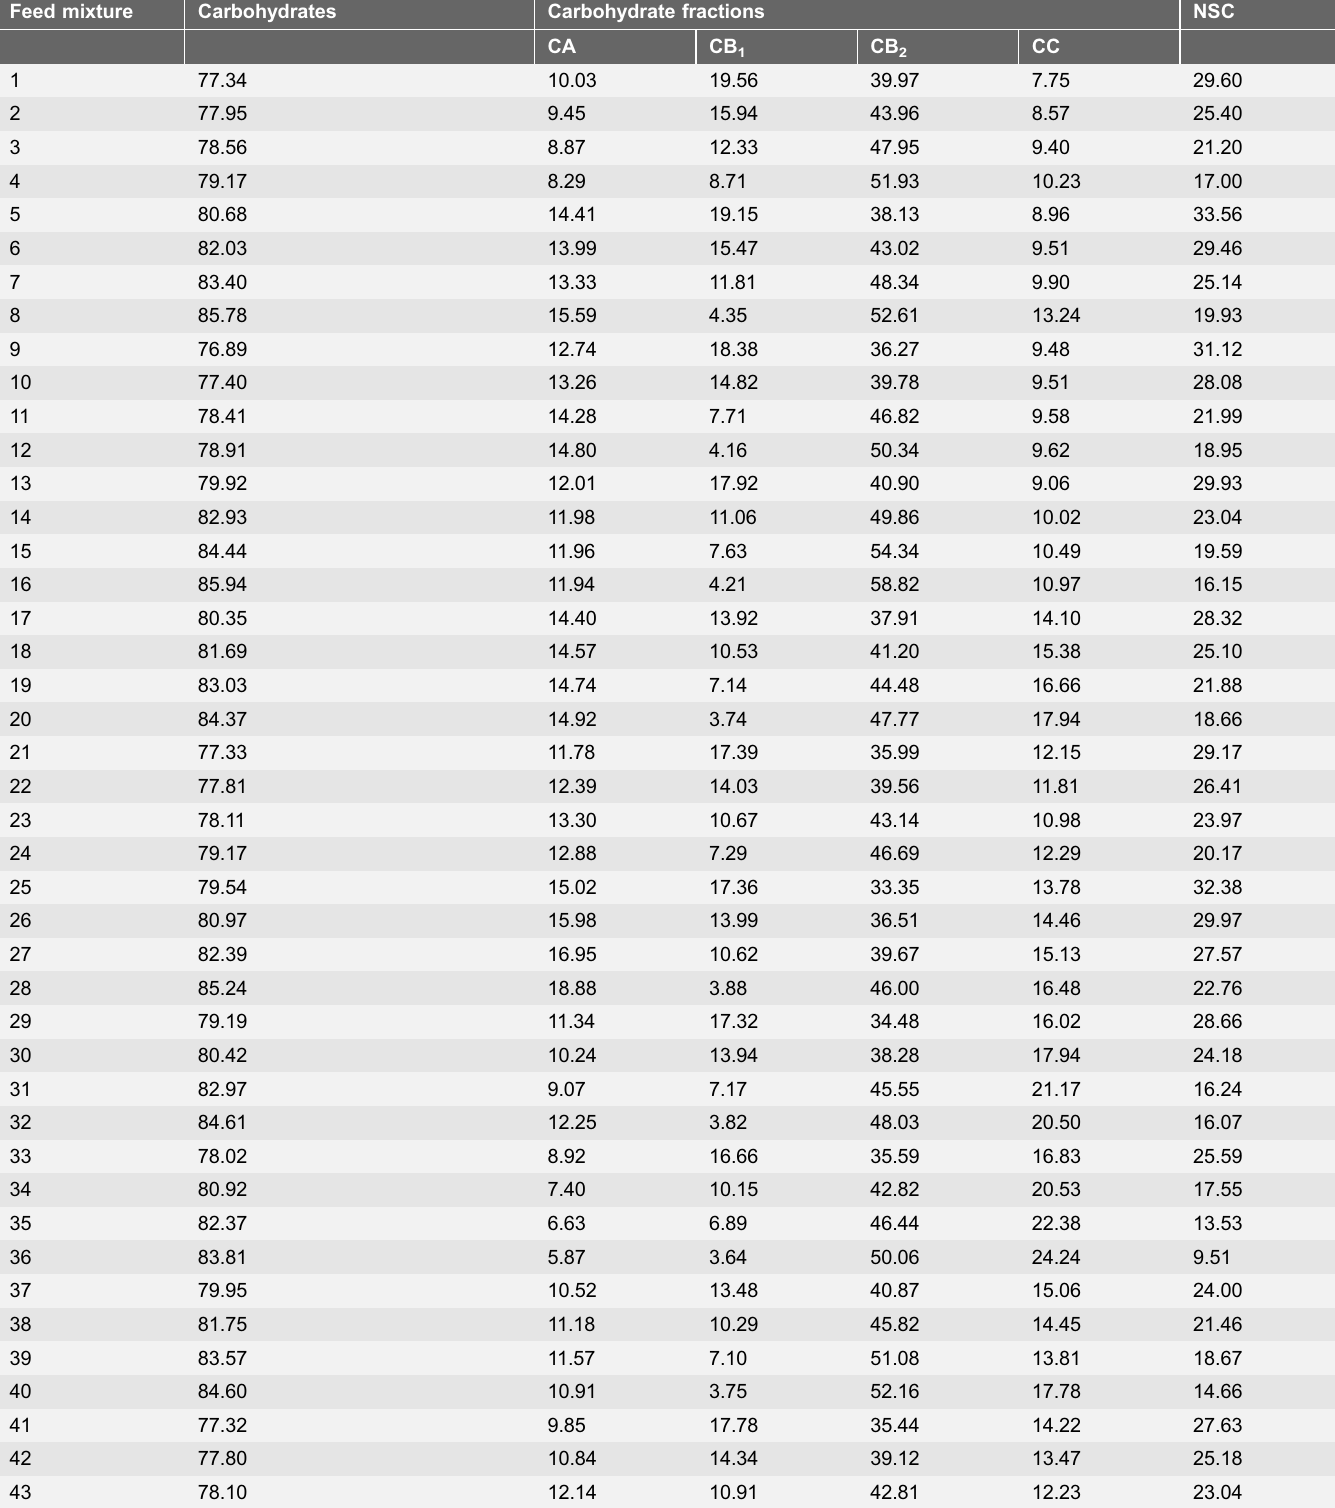
Table 3. The CNCPS carbohydrate fractions of feed mixtures for modeling (%DM). Feed